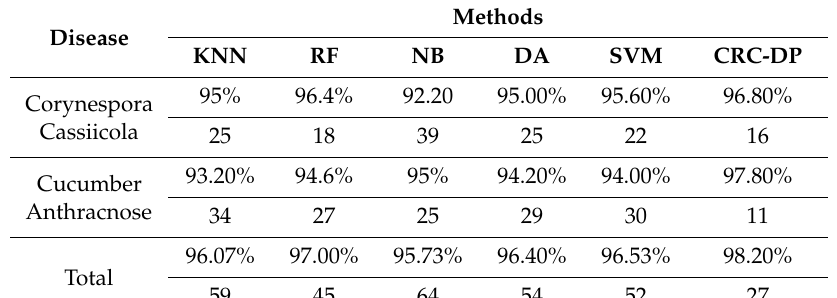
Table 1. The identification accuracies and the number of incorrectly diagnosed samples of different methods (for each disease, the quantitative results from top to bottom are the classification accuracy and the number of samples that were wrongly judged, respectively).